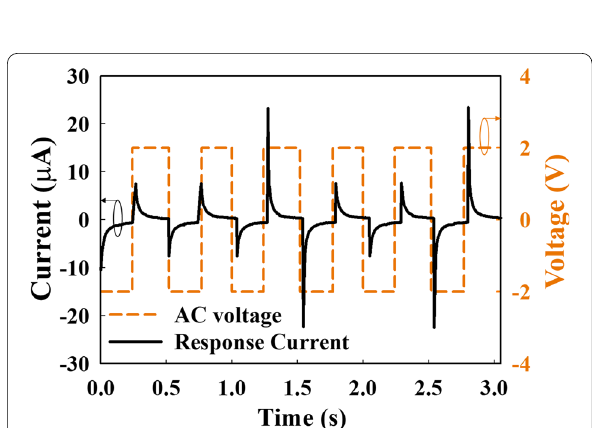
Fig. 3 The relationship between the input wave and I